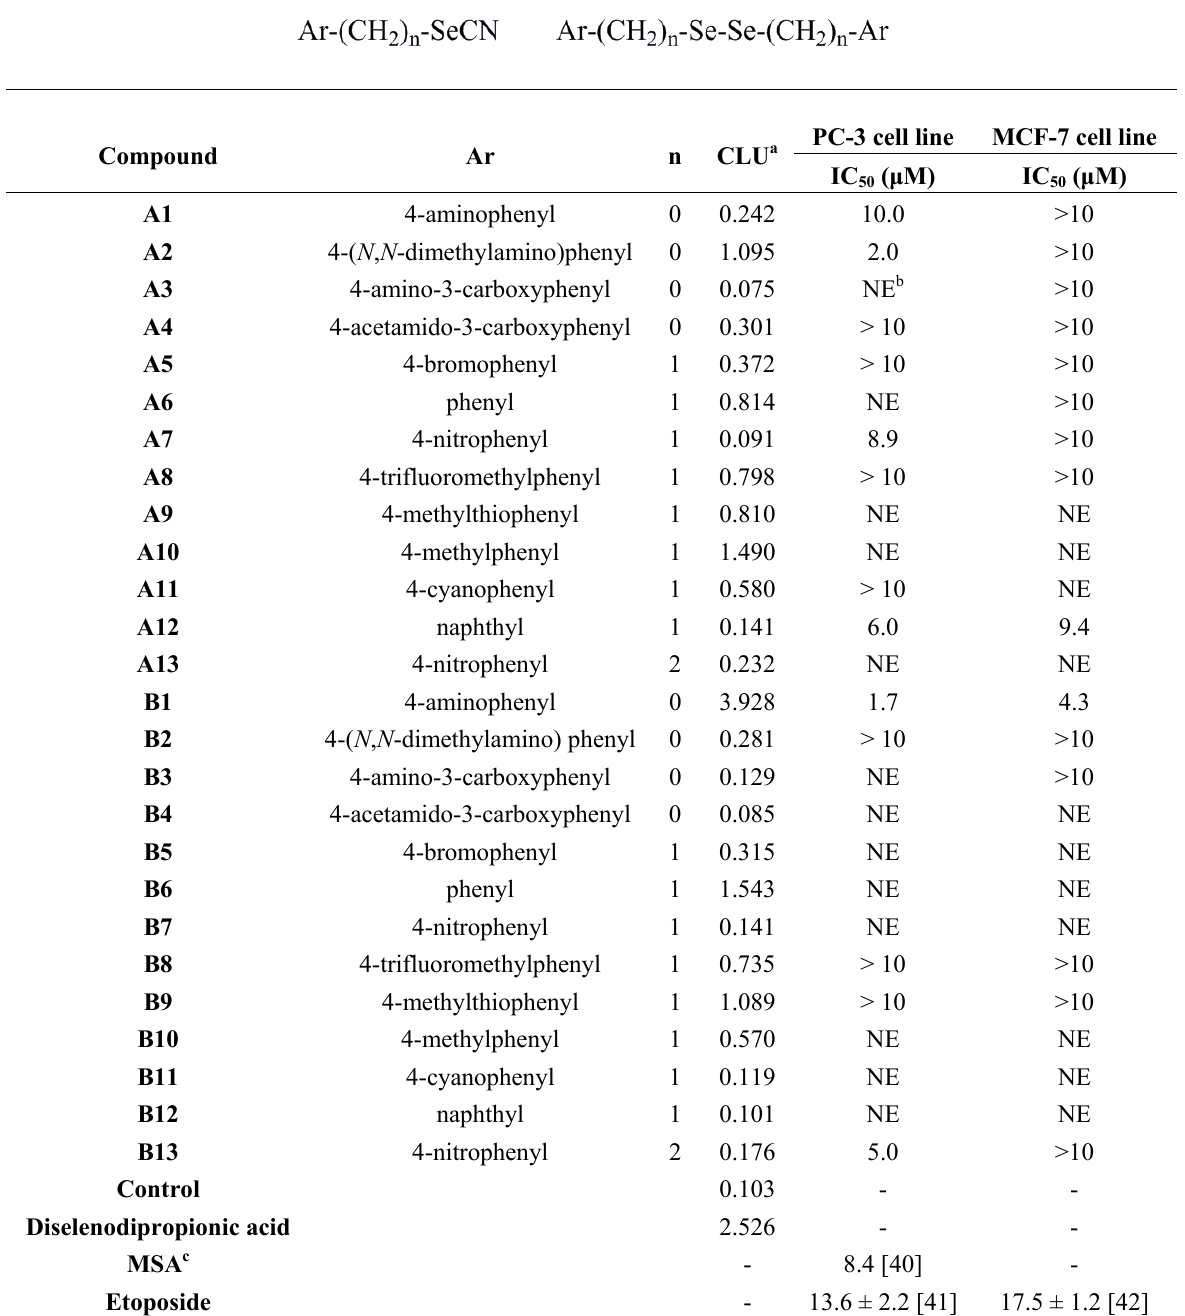
Table 2. Chemiluminescence (CLU) and cytotoxic activities (IC A13 and B1 - B13